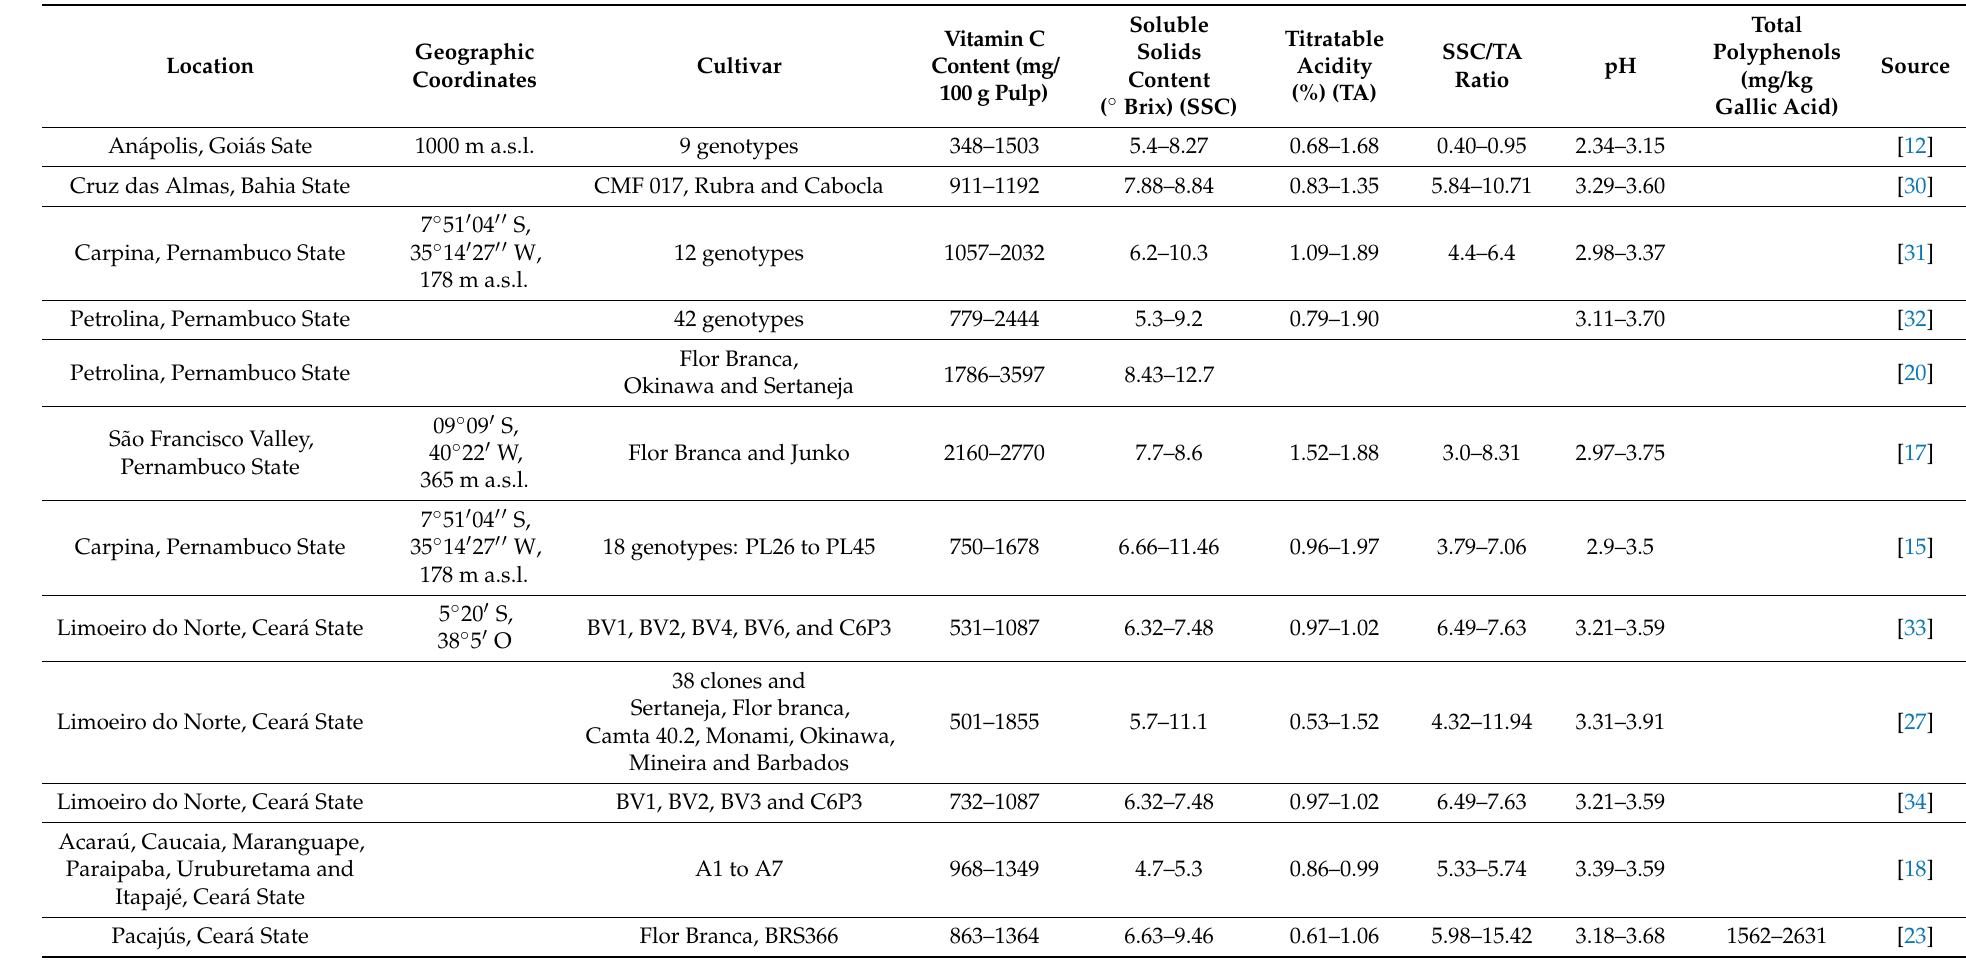
Table 1. Ranges of the principal acerola chemical characteristics reported in the literature from studies carried out in nine states of Brazil, with respect to ripe